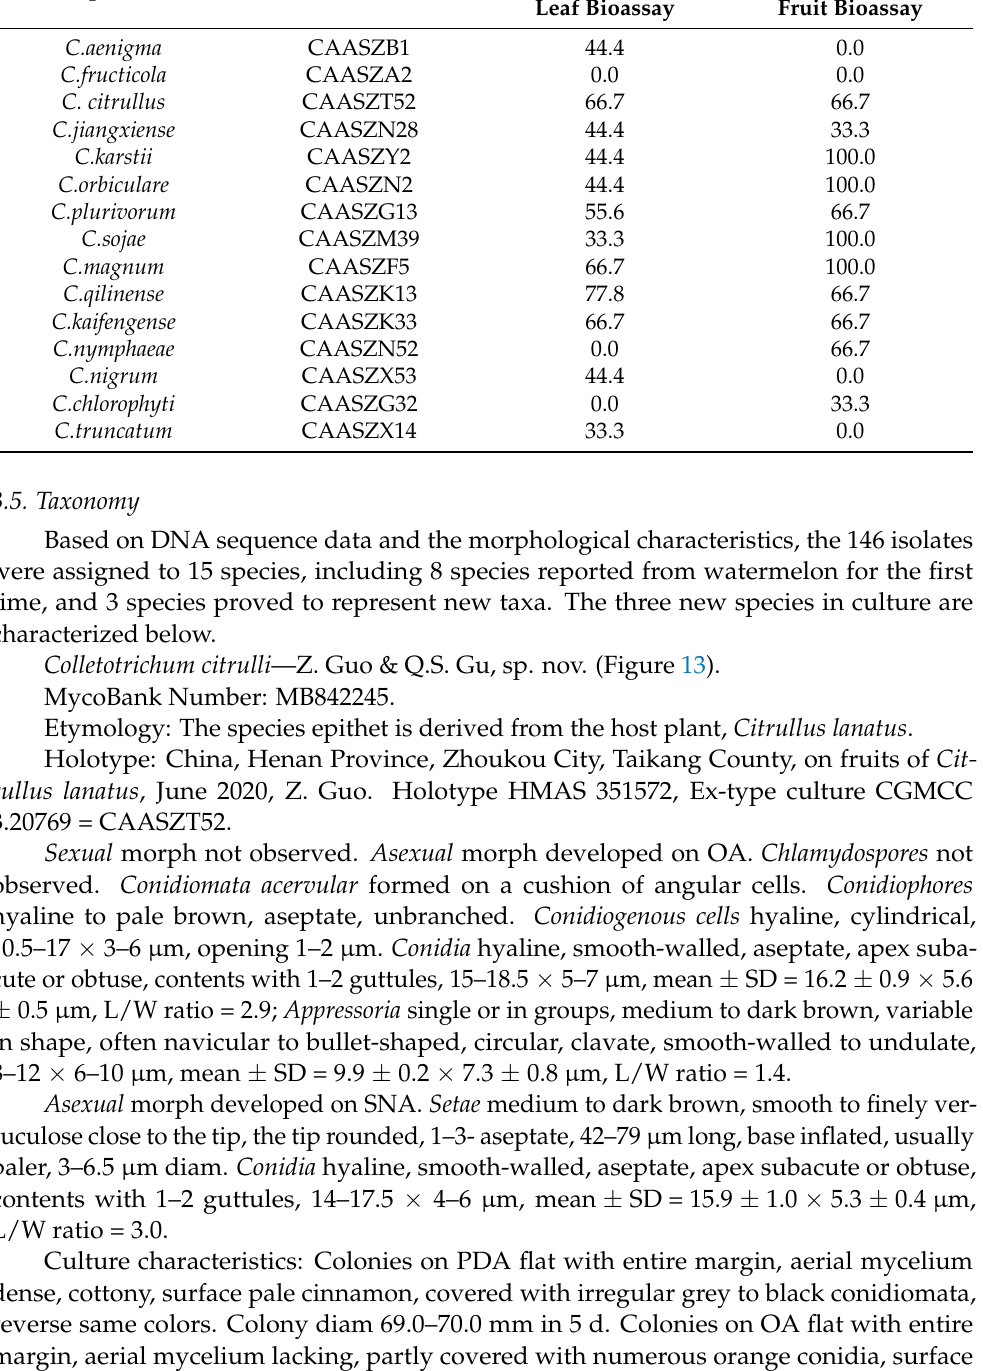
Table 3. Incidence of infection on leaves of Citrullus lanatus cv. Hongheping and fruit of Citrullus lanatus cv. Motong by Colletotrichum species. Infection Incidence % Species Strain Leaf Bioassay Fruit